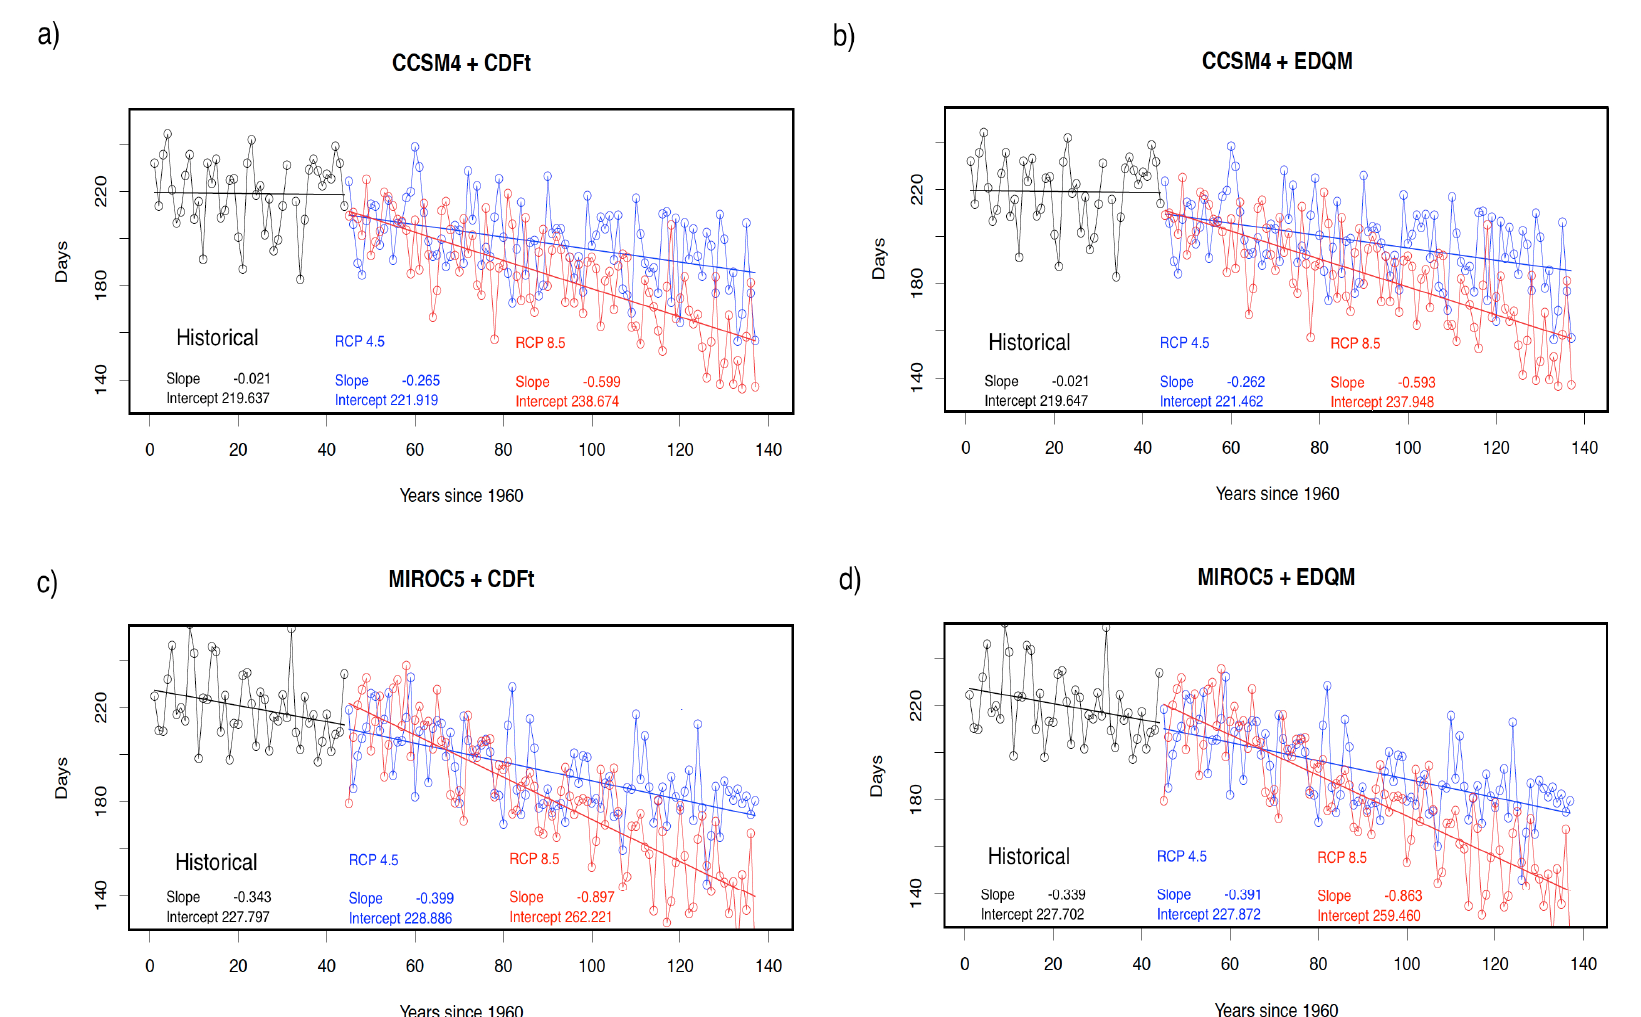
Figure 10. Number of days needed to reach 1825 GDD over the study period